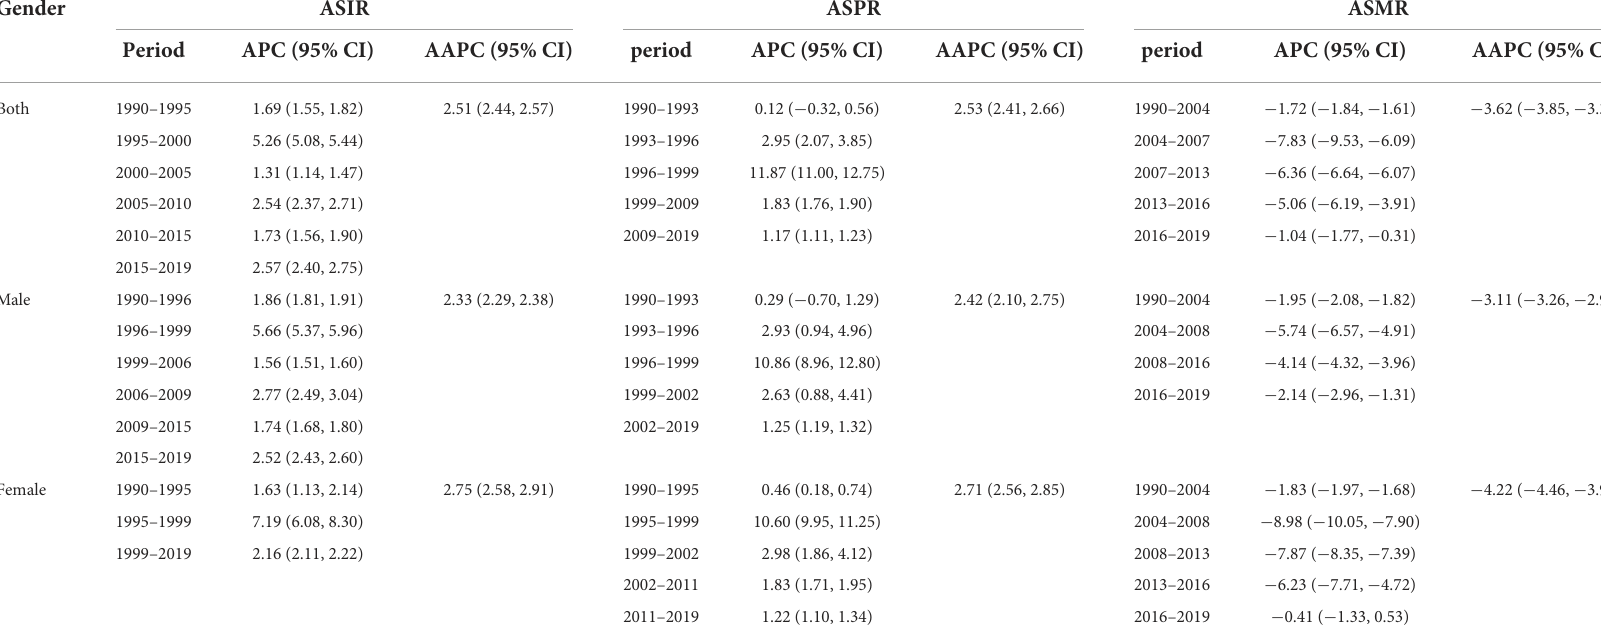
TABLE 2 Joinpoint regression analysis: trends in age-standardized incidence, prevalence, mortality rates (per 100,000 persons) among both sexes, males, and females in China, 1990–2019. Gender ASIR ASPR ASMR